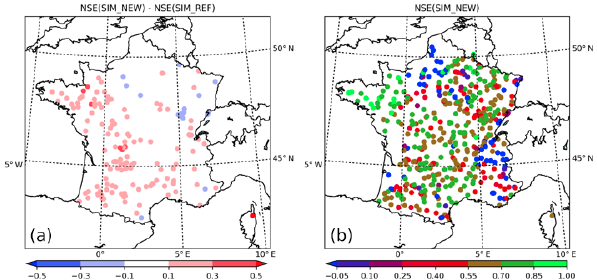
Figure 7. Map of the difference in mean NSE for NSE>0 between SIM_NEW and SIM_REF (a) and the SIM_NEW NSE map (b) .